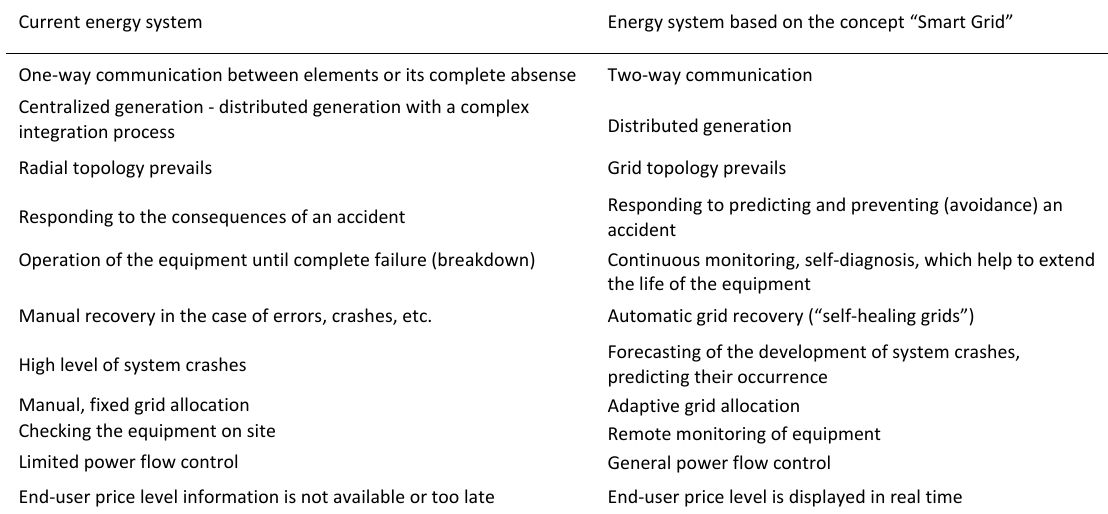
Table 4: Comparative characteristics of the functional characteristics of the current energy system and the energy system based on the concept of “Smart Grid” Current energy system